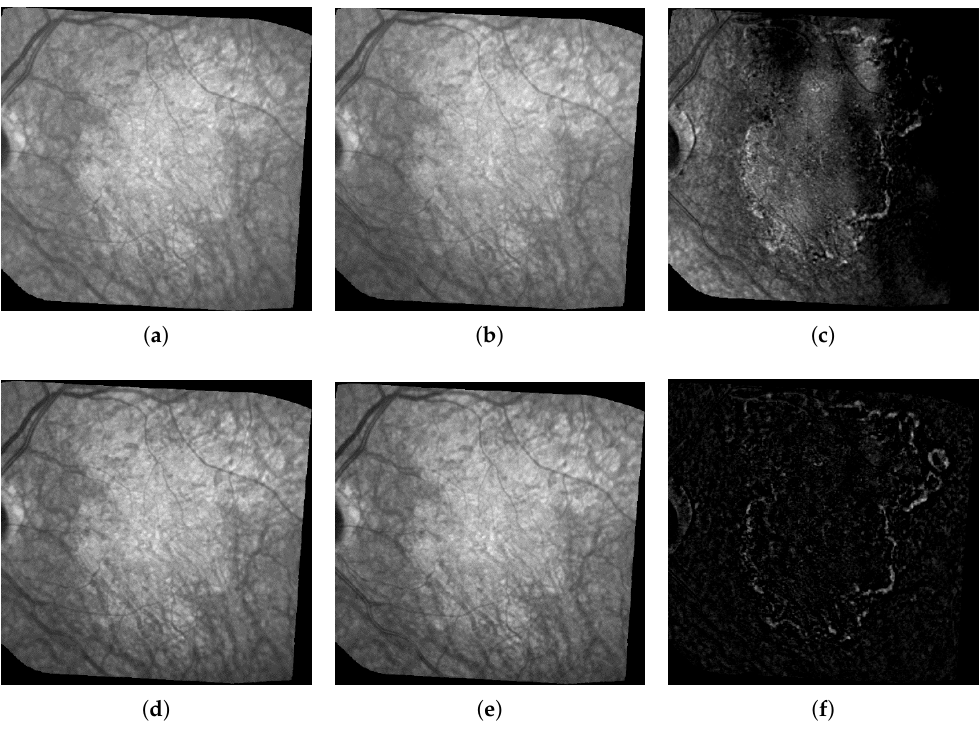
Figure 2. Example of Illumination correction. The three images on the top row represent the two original consecutive images ( a , b ), and their raw difference in absolute value ( c ); on the bottom row: the same images after illumination correction ( d , e ), and the new difference ( f